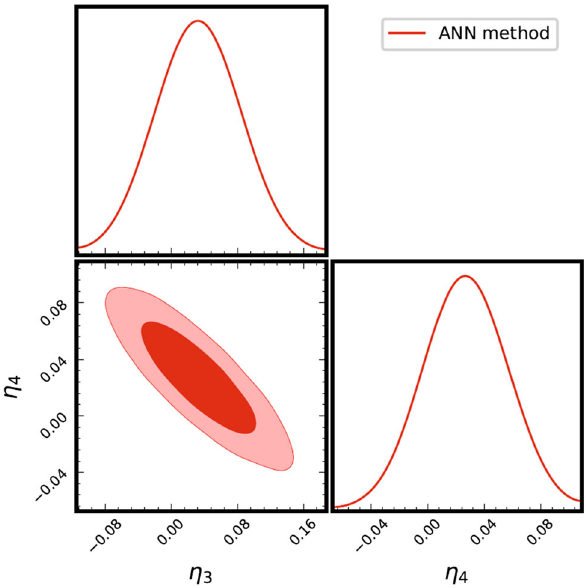
Fig. 8 The 1D and 2D marginalized probability distributions for the fourth CDDR parameters η 3 and η 4 by using ANN reconstructed HII galaxy and compact radio quasar